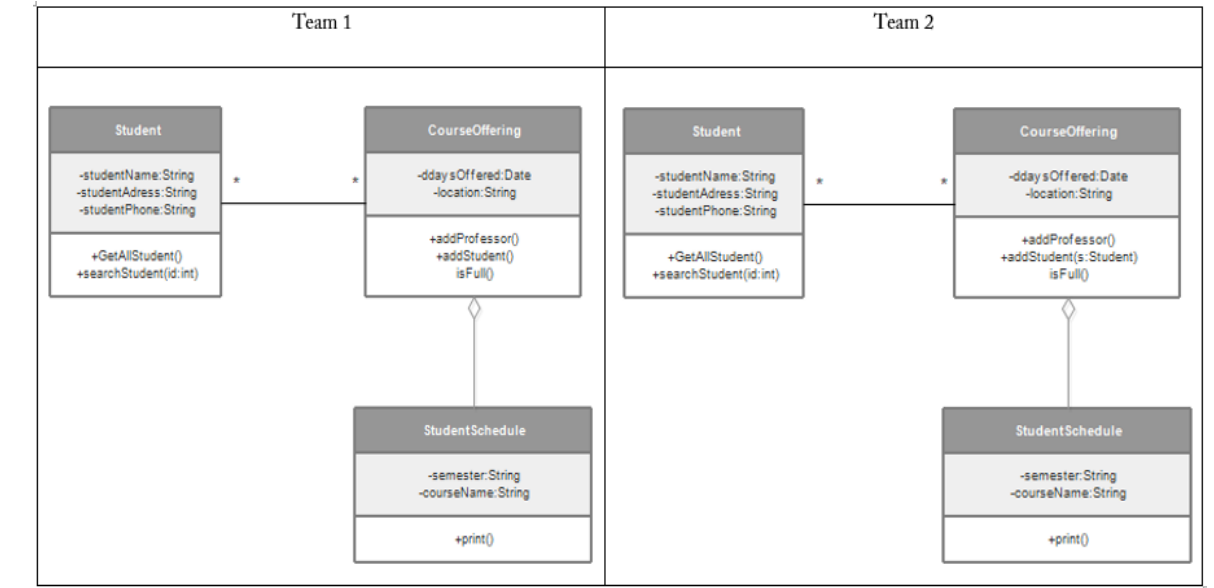
Fig. 4. Class diagrams made by two different teams: University artifacts.